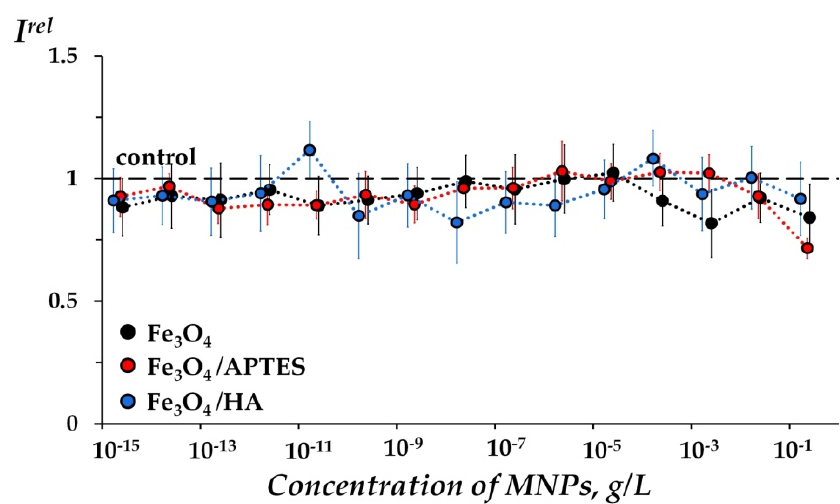
Figure 6. Relative bioluminescence intensity, I rel , vs. MNP concentration, g/L. Enzyme system. Bare Fe 3 O 4 –black circles, Fe 3 O 4 /APTES–red circles, and Fe 3 O 4 /HA–blue circles.